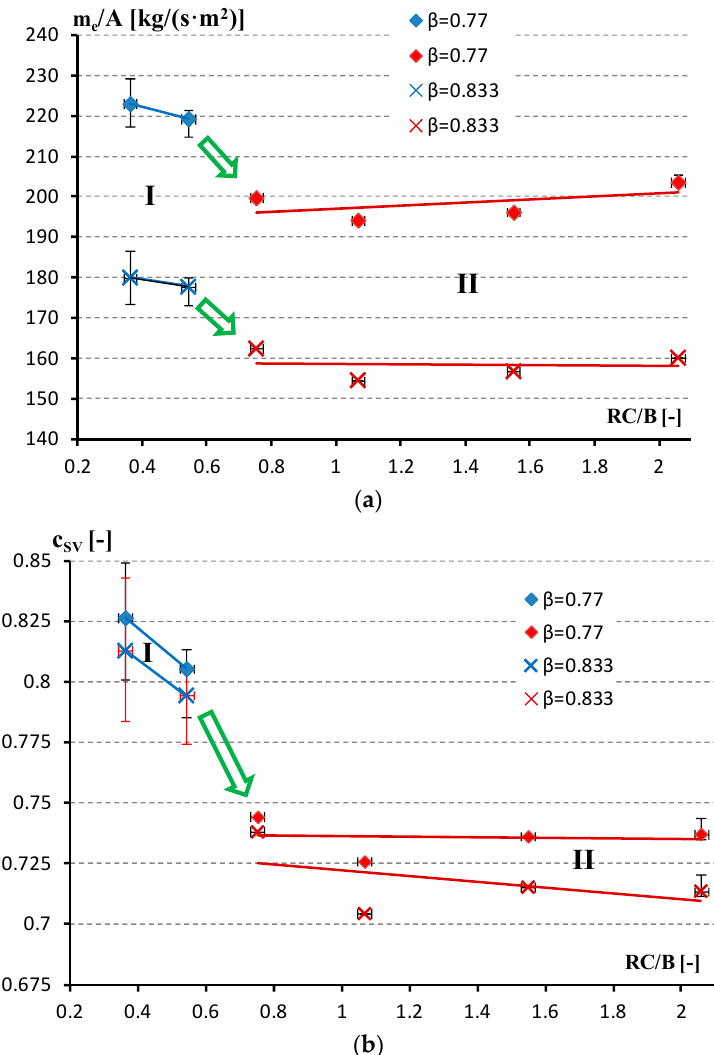
. m e /A and ( b ) c SV depending on RC / B